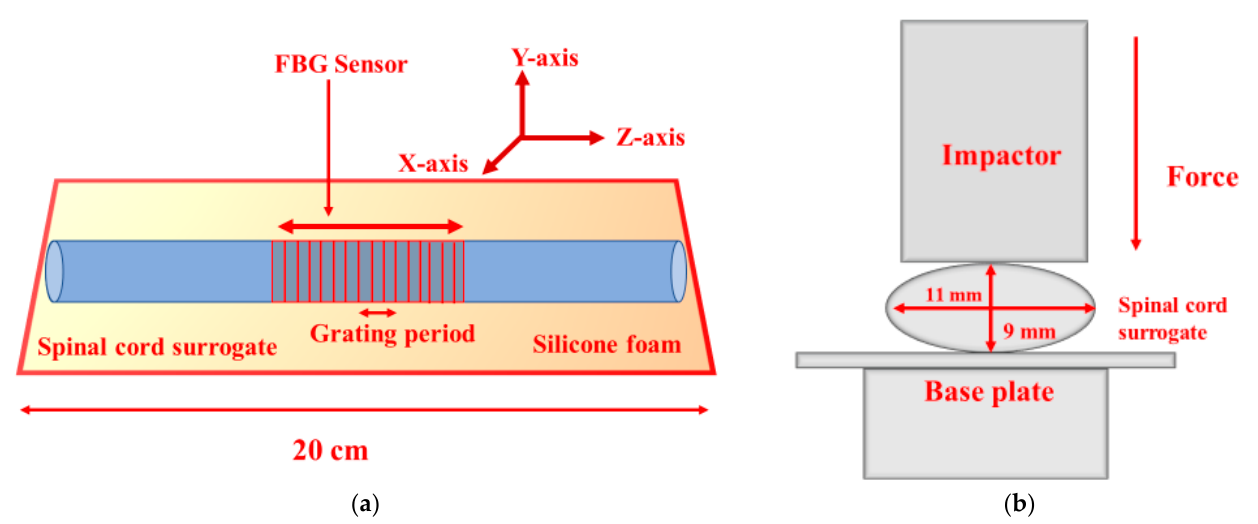
Figure 1. ( a ) Schematic representation of the longitudinal mid-cross-section of the instrumented spinal cord surrogate with the integrated fiber Bragg grating (FBG) sensor. ( b ) Transverse view of the mechanical and optical setup.